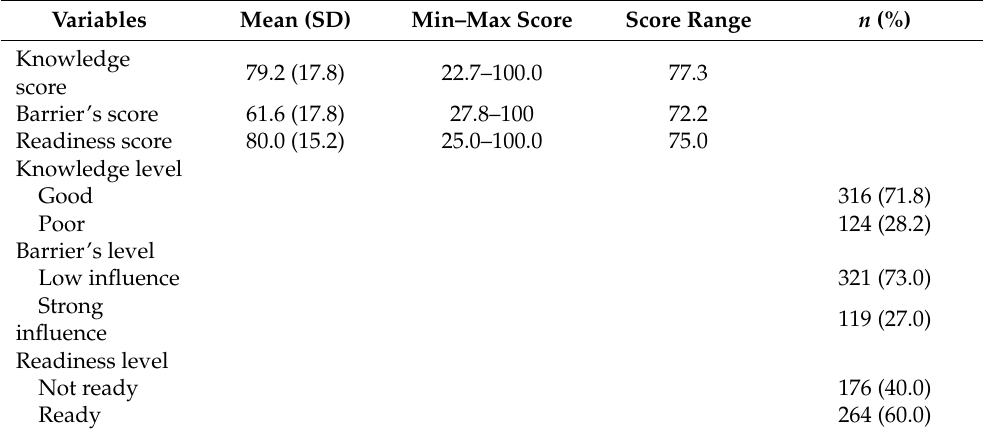
Table 2. Knowledge, readiness, barrier scores, and score levels of night market street food hawkers